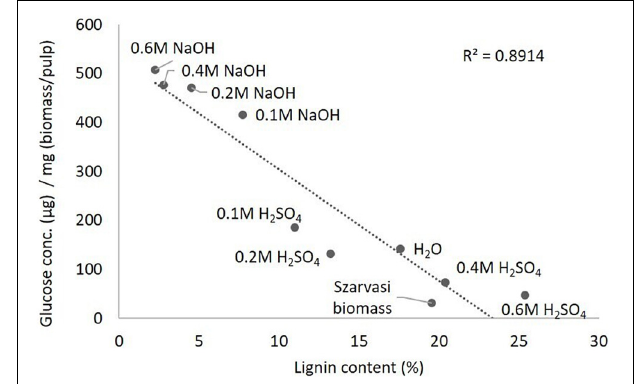
FIGURE 6 | Inverse correlation between lignin content ( Table 1 ) and glucose saccharification yield ( Table 2 ) of various pretreated Szarvasi